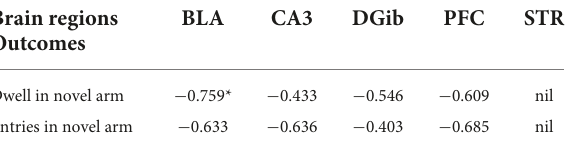
TABLE 3 The correlation between the microglia activation and quantitative outcomes of Y maze at 24 h in the I/R mice. Brain regions BLA CA3 DGib PFC STR Outcomes Dwell in novel arm − 0.759* − 0.433 − 0.546 − 0.609 nil Entries in novel arm − 0.633 − 0.636 −